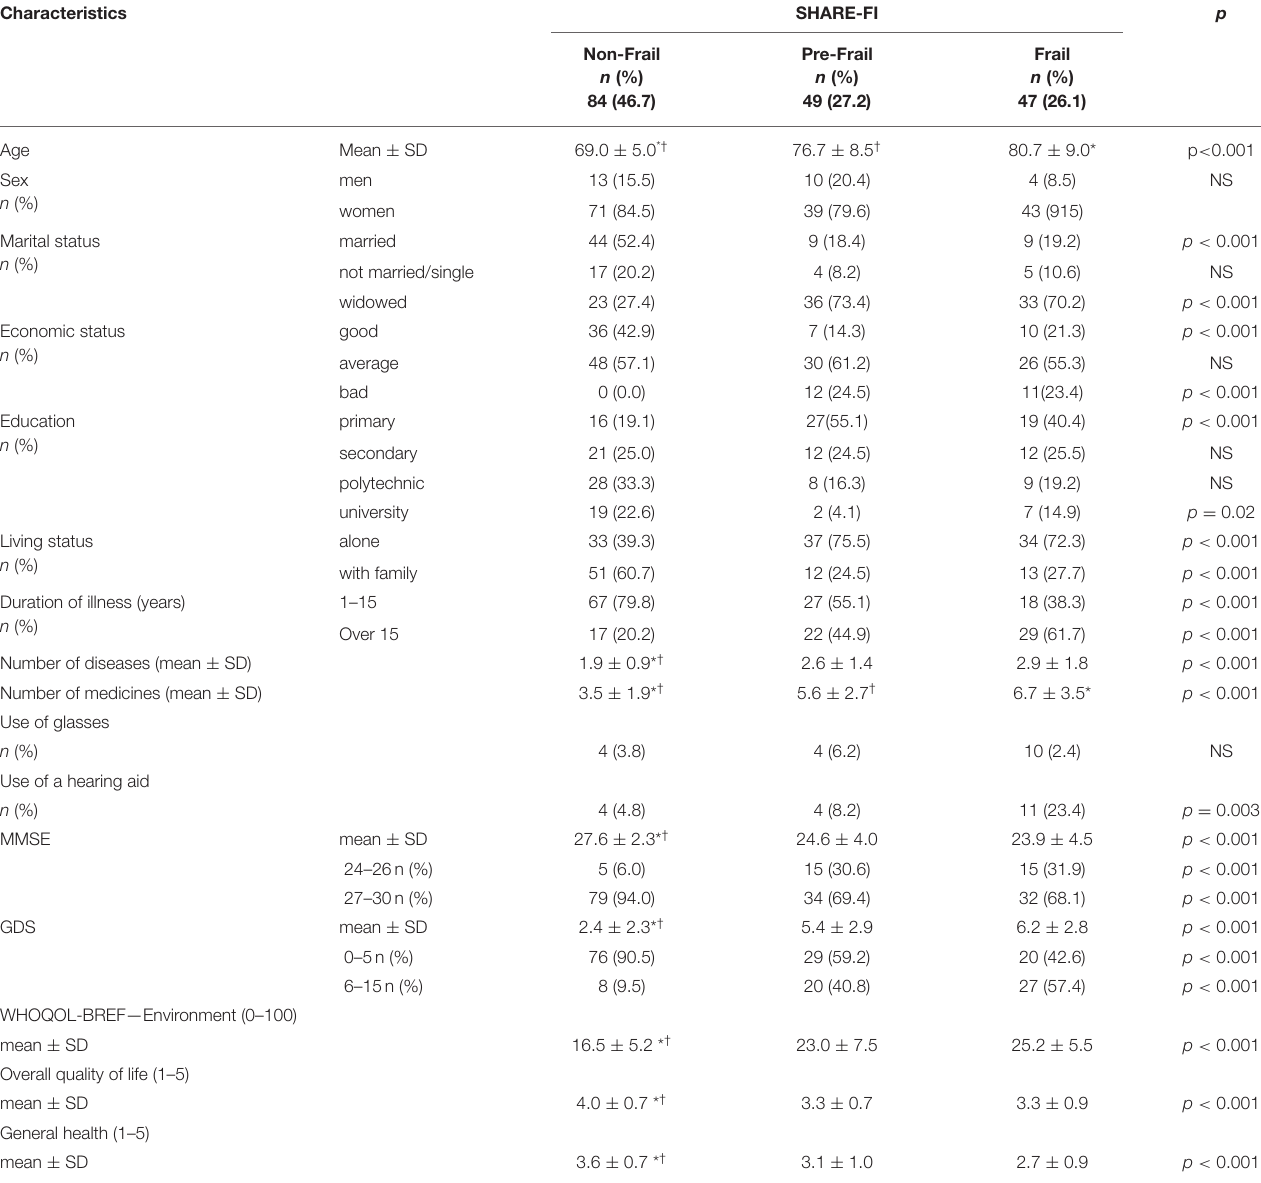
TABLE 3 | Sociodemographic and clinical characteristics according to SHARE-FI in the study group ( n = 180).